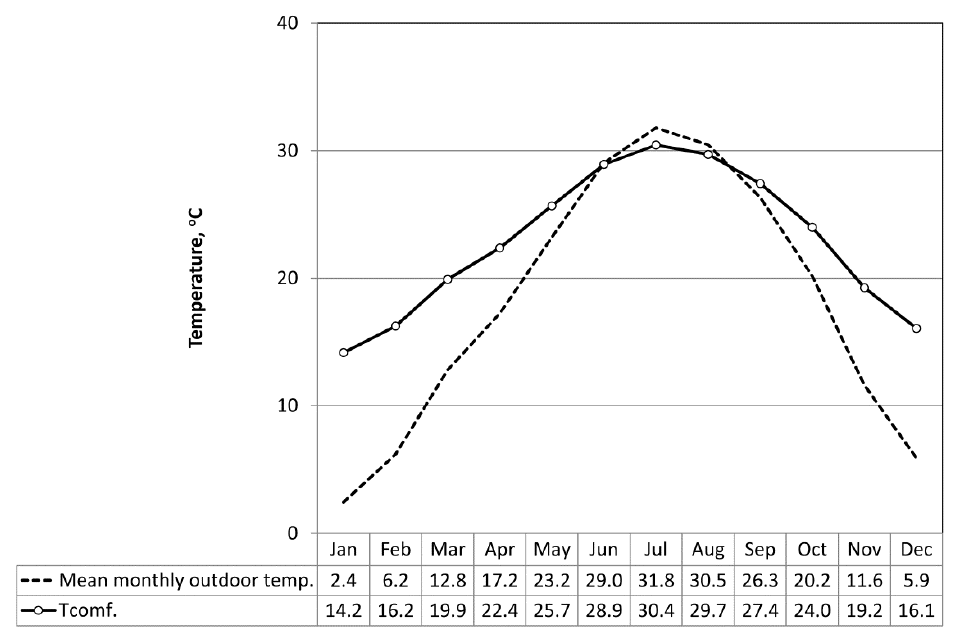
Figure 3. Mean monthly outdoor and occupant comfort temperature for